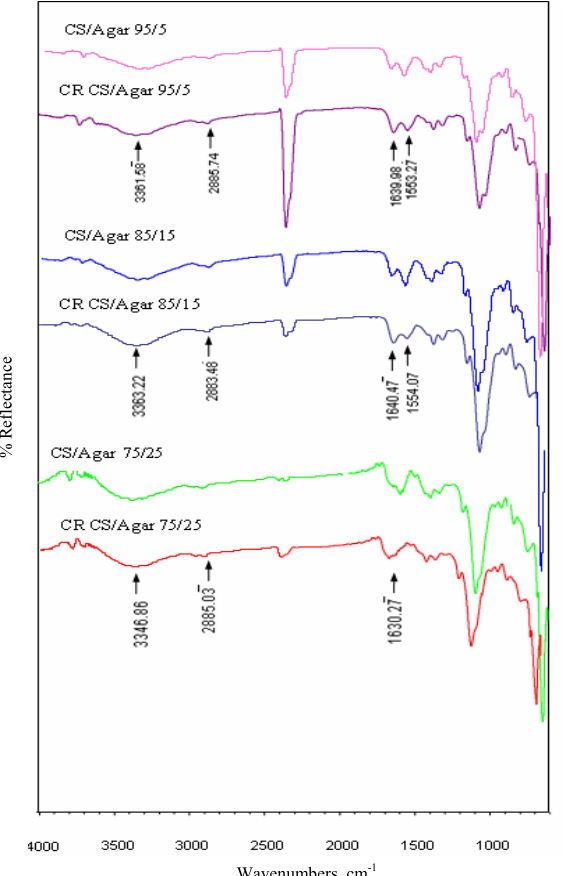
Figure 5. FTIR-ATR spectra of crosslinked (CR) chitosan/agar blended films together with non-crosslinked